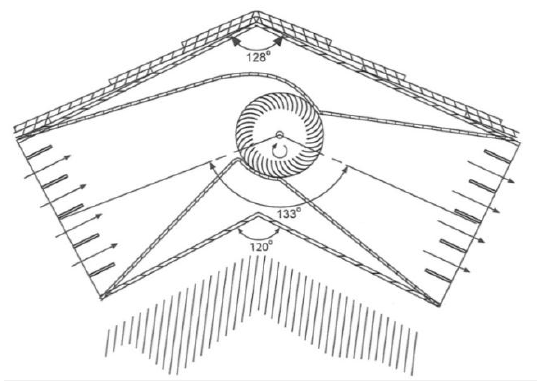
Figure 2. Wind power generation system on double slope roof. Reprint with permission [38]; 2011, United States Patent Application Publication.